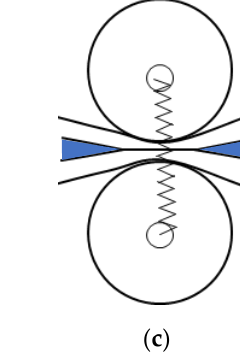
Figure 2. Different configuration of the rollers: ( a ) Distance between rollers is imposed; ( b ) decreased thickness due to wear leads to leakage in configuration a); ( c ) force between rollers is imposed.